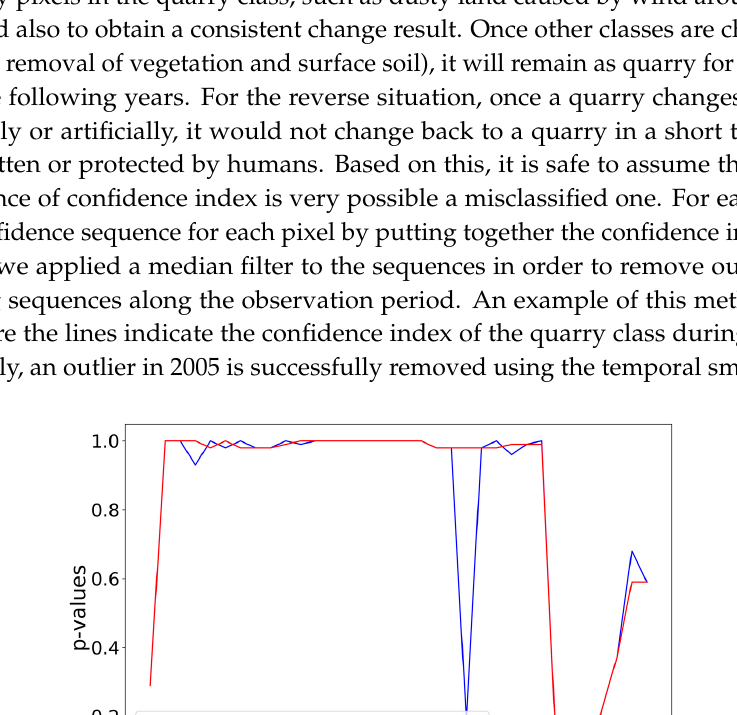
Figure 3. ( a ) DSM image of the study area; ( b ) Altitude mask of the study area. Temporal Smoothing